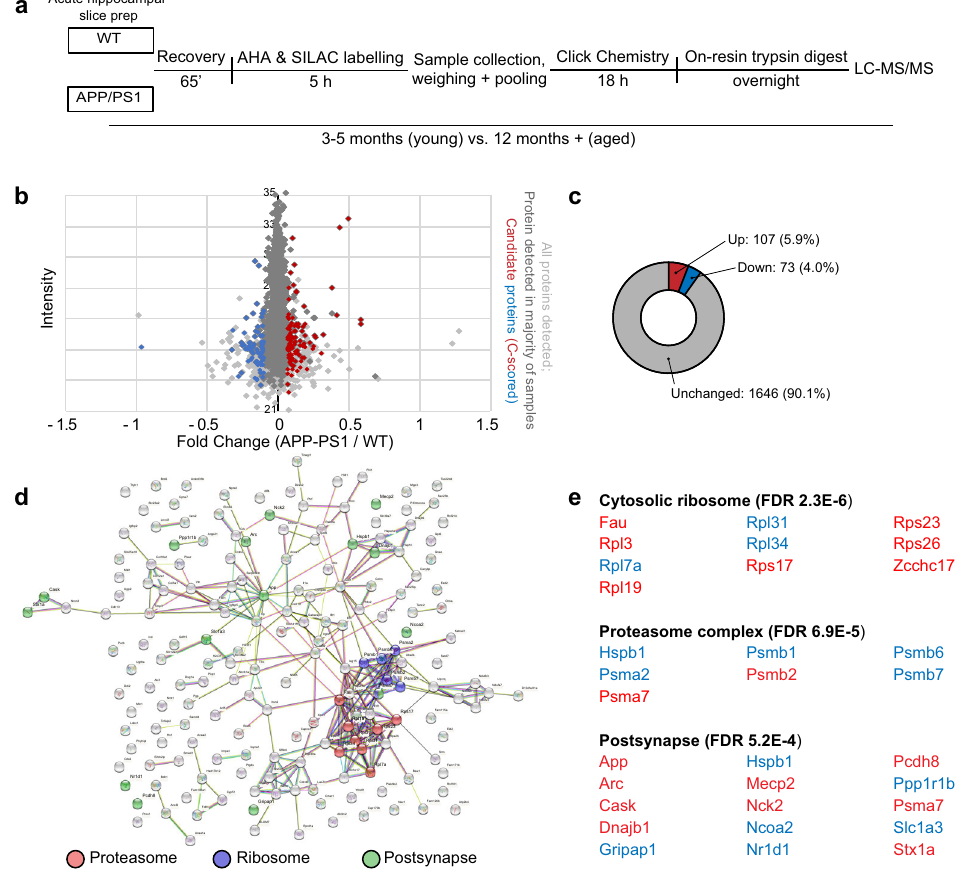
Fig. 2 Steady state proteome differs in young wild-type and APP/PS1 mouse hippocampus. a Schematic and timeline of BONLAC labelling protocol. b Fold change vs. intensity distribution plot of all newly made proteins detected in wild-type (WT) vs. 3 – 5-month-old APP/PS1 hippocampus (light grey), with proteins that were detected in majority of samples (>3 out of fi ve biologically independent samples; grey) and dysregulated candidate proteins identi fi ed by C-score screen (upregulated ≥ 20% in red, downregulated ≤ 20% in blue). c Doughnut plot showing the proportion of detected proteins that were downregulated (fold change < 0.8, blue), upregulated (fold change> 1.2, red) or unchanged in the majority of 3 – 5-month-old APP/PS1 mice compared to WT littermates. d String diagram depicting enriched gene ontology groups. e Top functional clusters in 3 – 5-month-old APP/PS1 mice compared to WT using DAVID. Red = upregulated proteins. Blue = downregulated